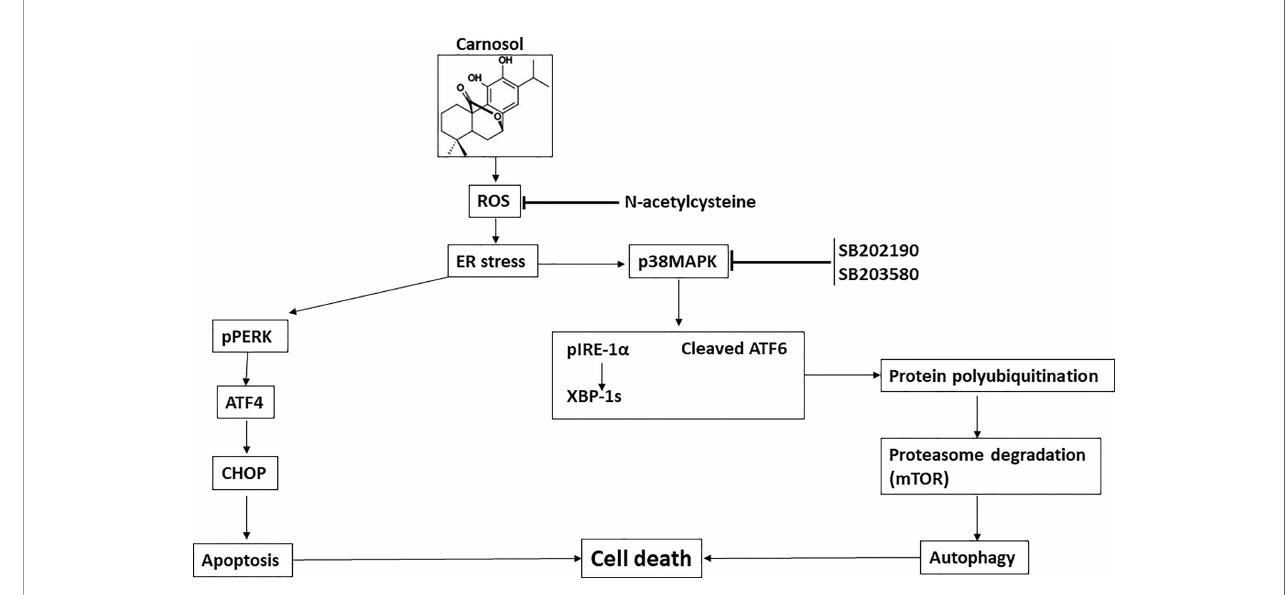
FIGURE 9 | Hypothetic model for the anti-breast cancer effect of